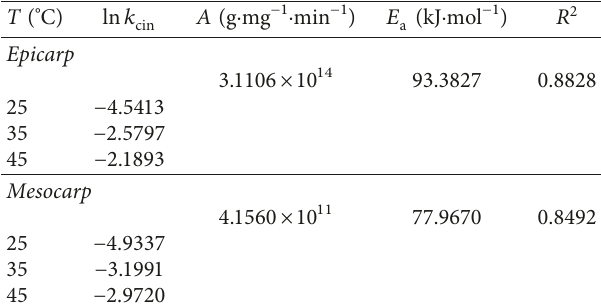
Table 6: Parameters of the Arrhenius equation for adsorption of fluoride ions on epicarp and mesocarp of green